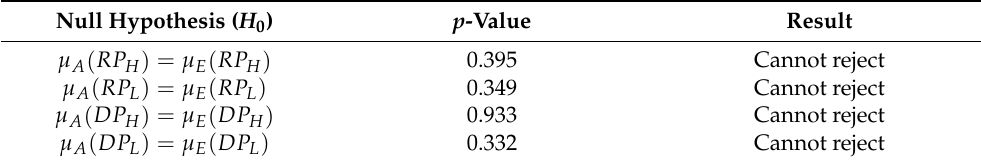
Figure 15. Prices in A and E of: ( a ) high-quality product in retail channel; ( b ) low-quality product in retail channel; ( c ) high-quality product in direct sales channel; ( d ) low-quality product in direct sales channel. ( t = 100).